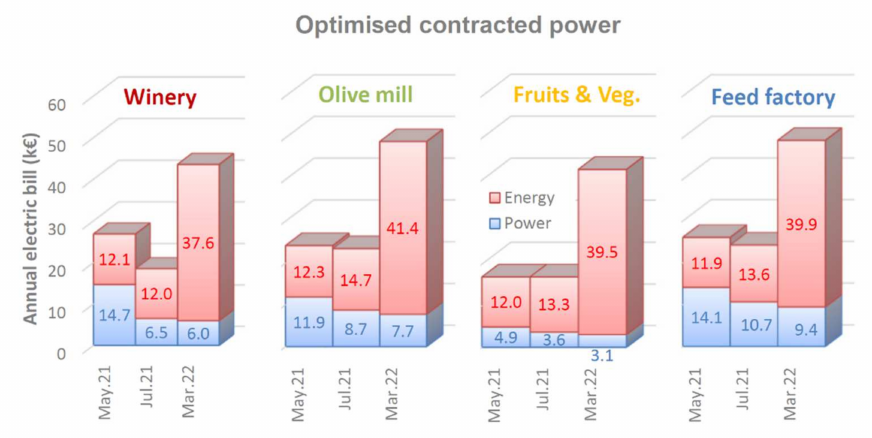
Figure 6. Annual electricity bill amount under three different scenarios and prices, with optimised contracted power: former tariff system with prices as of May 2021, current tariff system with prices as of July 2021, and current tariff system with current prices as of March